Question: Generate an informative caption for the figure above.
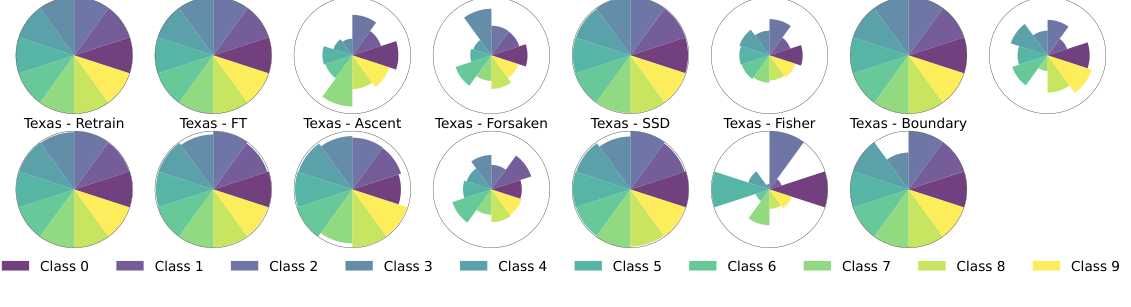
Answer: Total class unlearning results (AUC) of 10 classes